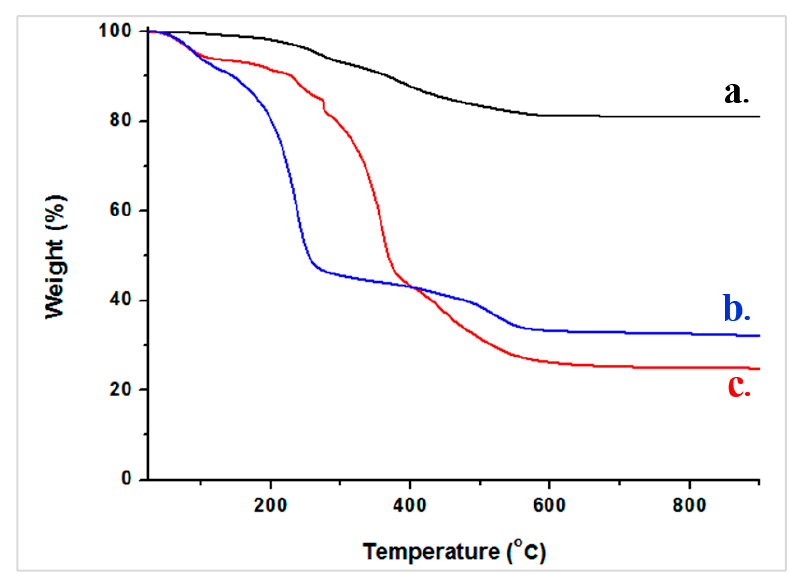
Figure 12. TGA analysis of ( a ) hydrophobic magnetite nanoparticles coated with oleic acid (MNP-OA), ( b ) chiral PMO NPs, and ( c ) chiral magnetic PMO NPs.